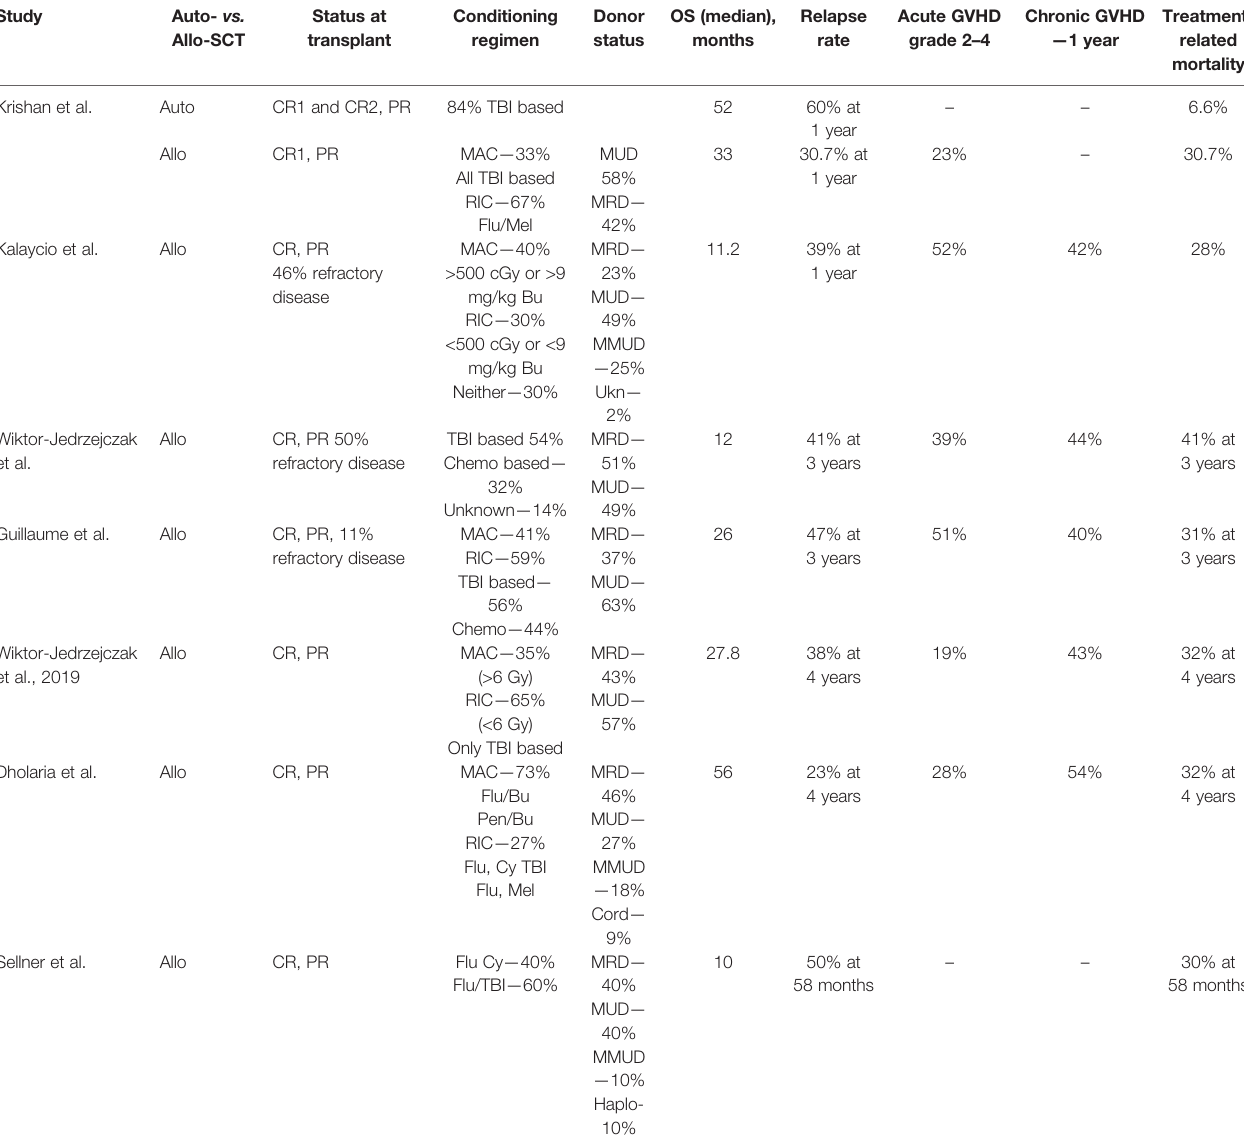
TABLE 1 | Studies of Stem cell transplant for PLL. Study Auto-